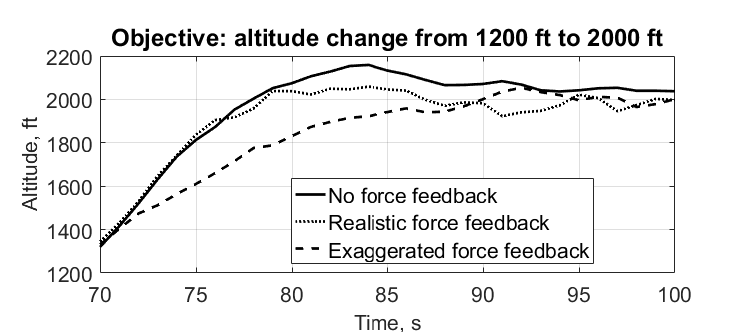
Figure 10. Altitude analysis at 1200 ft.